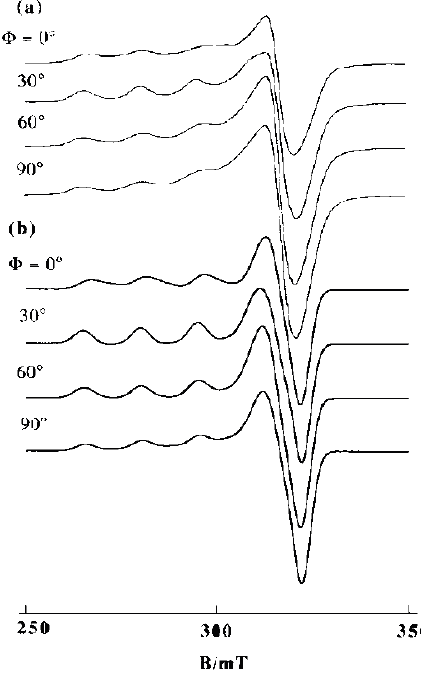
Figure 18. Observed ( a ) and calculated ( b ) EPR spectra of [Cu(bpy)(H 2 O) 3 ] on B-form DNA fibers at room temperature. [DNA-bp]/[Cu(II)] = 25, species A : θ = 40°, Δθ = 20°; species B : randomly oriented. For both A and B , g || = 2.280, g ⊥ = 2.08, A || = 0.0149 cm − 1 , = 0.0010 cm − 1 A N|| = 0.0010 cm − 1 , (cid:1827) (cid:1827) (cid:2884)